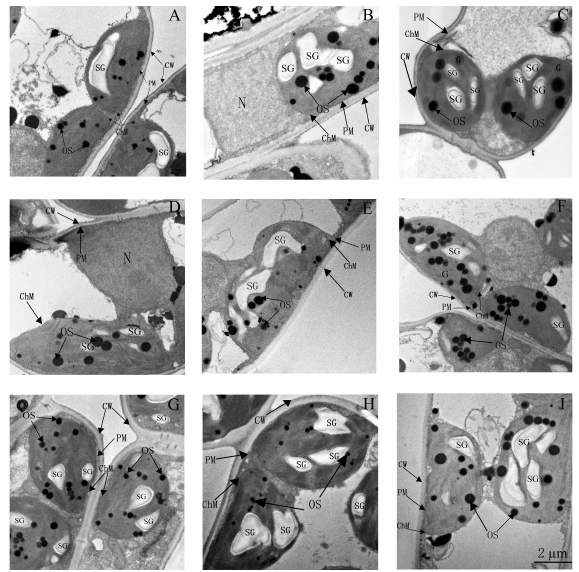
Figure 7. Ultrastructure of chloroplasts of leaves of black locust seedlings at three levels of salt stress (0, 100, or 200 mM NaCl), or with salt stress imposed after pretreatment with 1.04 µ M 24-epiBL by either seed soaking, foliar spraying, or roots dipping (see Table 1 for treatment designation). ( A ) CK; ( I ) Diw-1.04S2. CW: cell wall, PM: plasma membrane, ChM: chloroplast membrane, SG: starch granule, OS: osmiophilic plastoglobuli. Scale bars for chloroplasts are 2 µ m. Other details as in Figure 1.